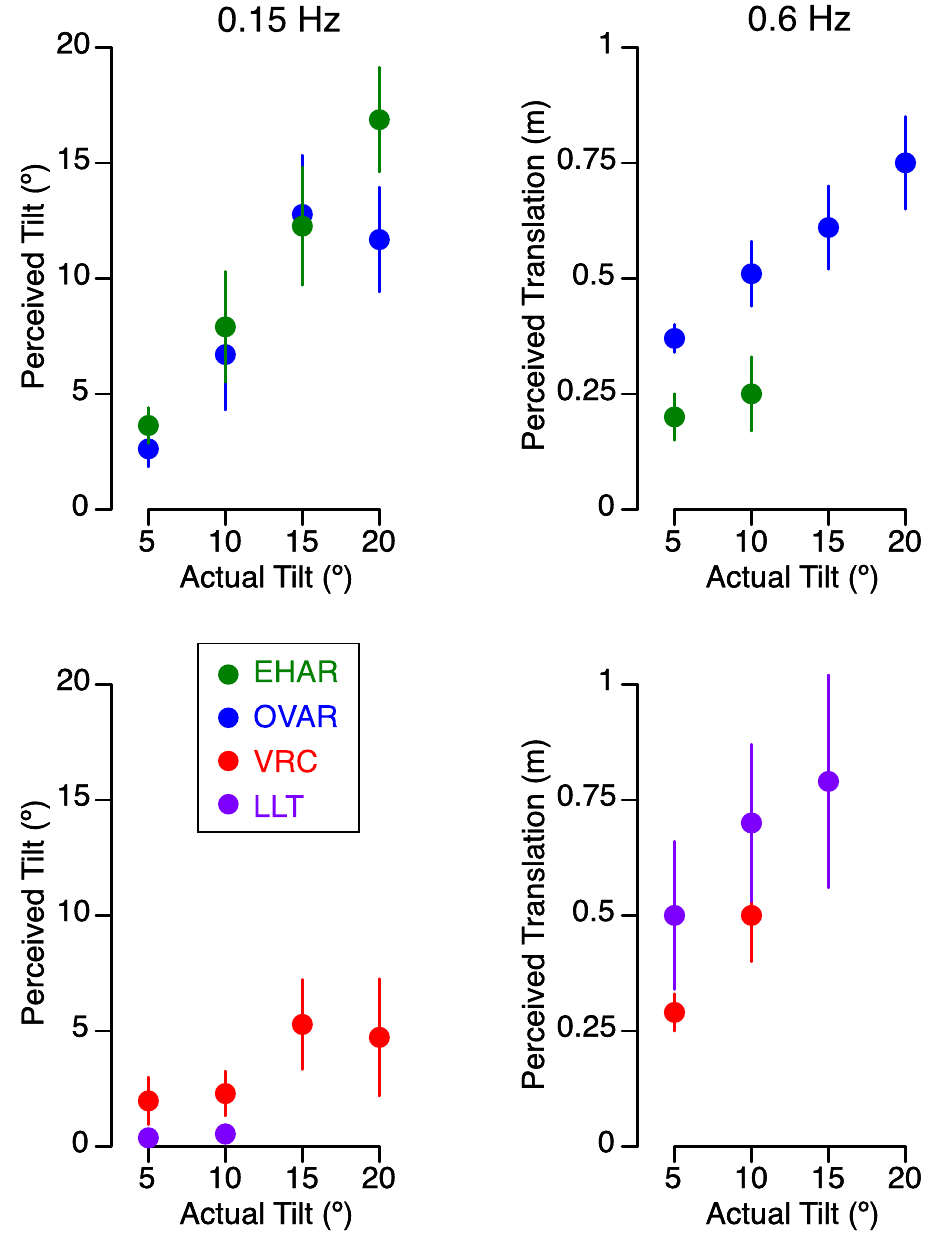
clarification of trials conducted at each angle and